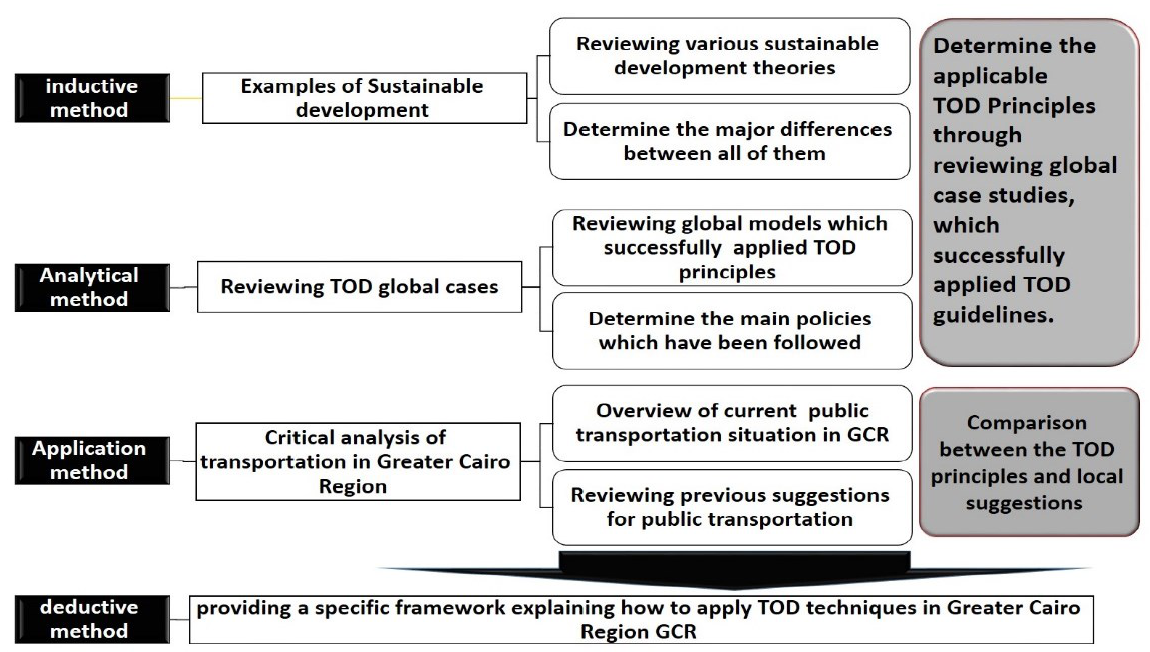
Figure 1. Methodology of the study (Developed by the